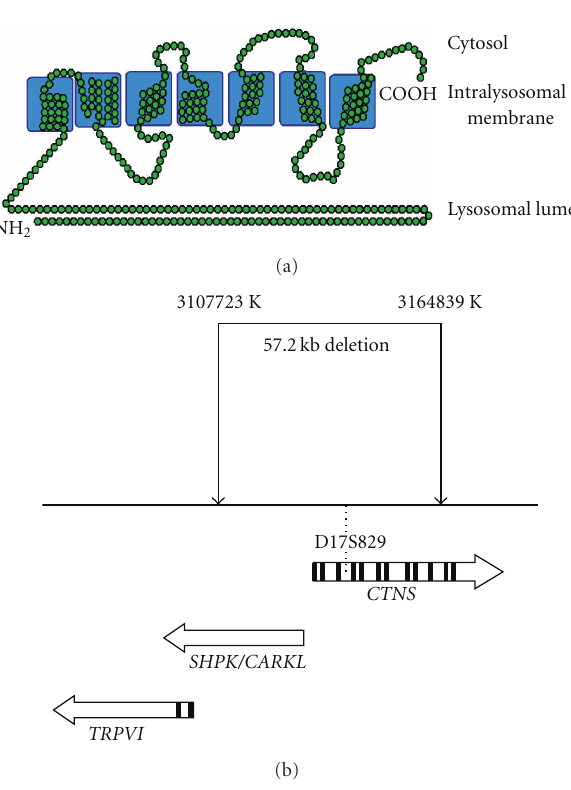
Figure 1: (a) Depiction of CTNS protein spanning the lysosomal membrane, (b) the common 57.2 kb deletion extending upstream from CTNS exon 10 through the first two exons of TRPV1 .